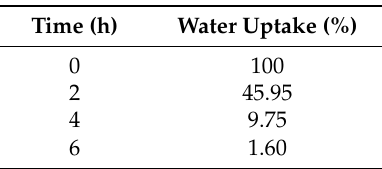
Figure 1. Water uptake data for CA / Ni(NO 3 ) 2 · 6H 2 O measured as a function of time (h). Table 1. Water uptake data.